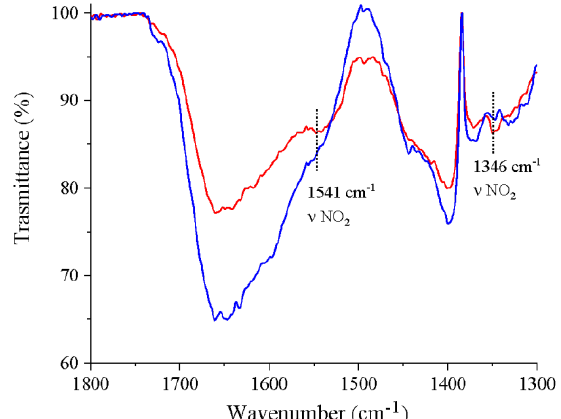
Figure 4. Infrared spectra of 4-nitrobenzaldehyde adsorbed on CdS/TiO 2 before ( red ) and after 150 ′ visible irradiation ( blue ).